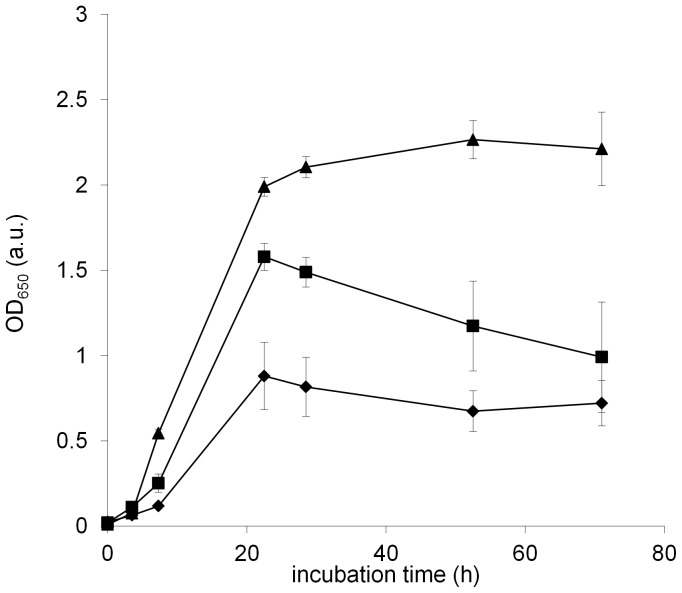
Optical densities (OD650) of standing cultures of B. subtilis grown in SYM (▴), Czapek (▪) and MSgg (♦).One of the four replicates is shown, with error bars representing standard deviations.